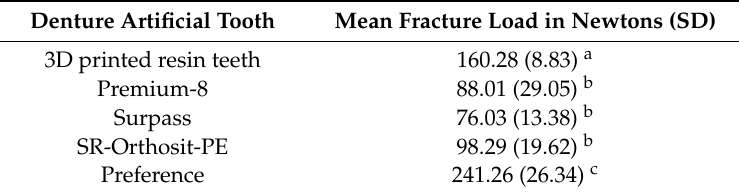
Table 3. Results of the indirect tensile fracture test.